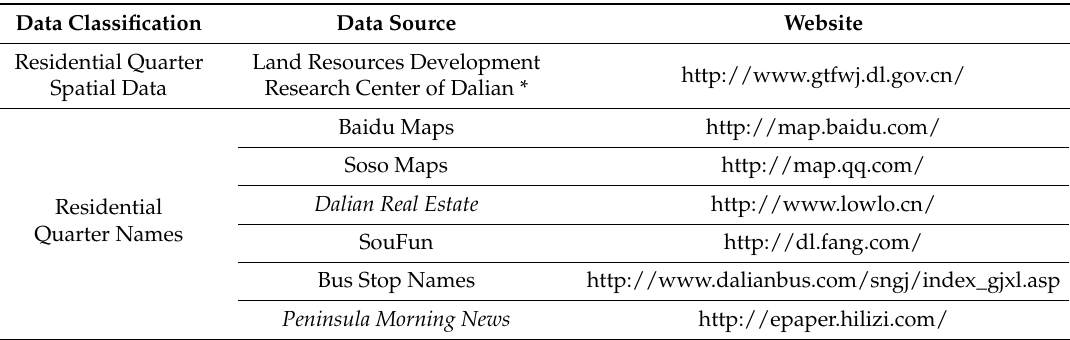
Figure 1. Map of the study area. Table 2. Data source illustration.